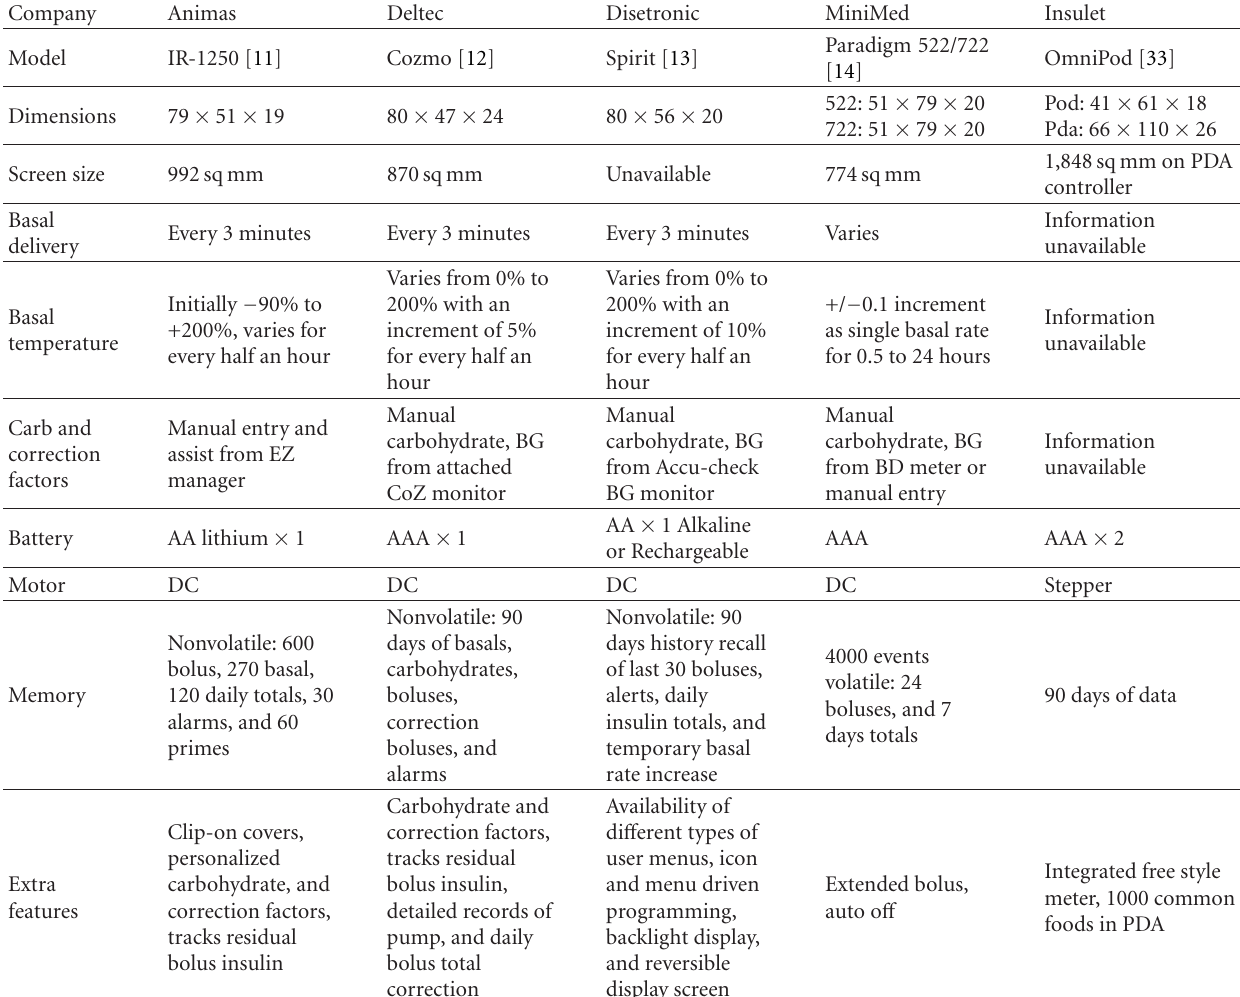
Table 1: Specification comparison of commercial insulin